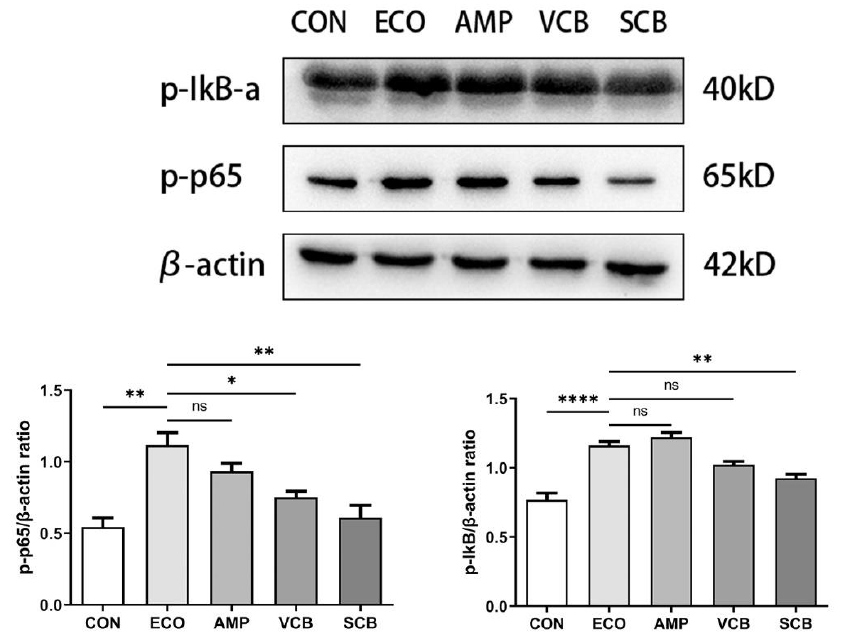
Figure 7. The supernatant of C. butyricum inhibited the activation of the NF- κ B signaling pathway induced by E. coli . Western blot was used to measure p-p65 and p-I κ B proteins in uterine tissues. β -Actin was used as a control. The values presented are the means ± SEM ( n = 3). * p < 0.05, ** p < 0.01 and **** p < 0.0001 are significantly different from ECO